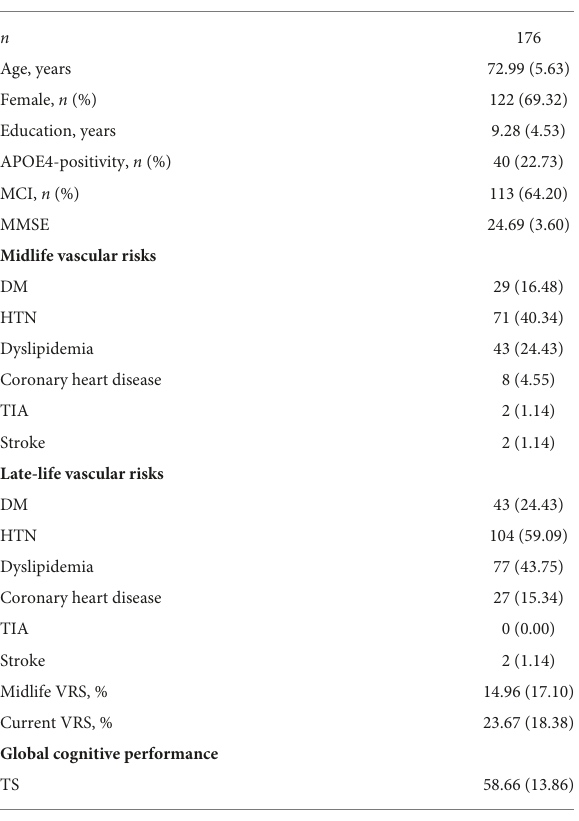
TABLE 2 The results of multiple linear regression analyses, including the interaction terms between vascular risks (DM, HTN, dyslipidemia, coronary heart disease, TIA, or stroke) in terms of predicting the